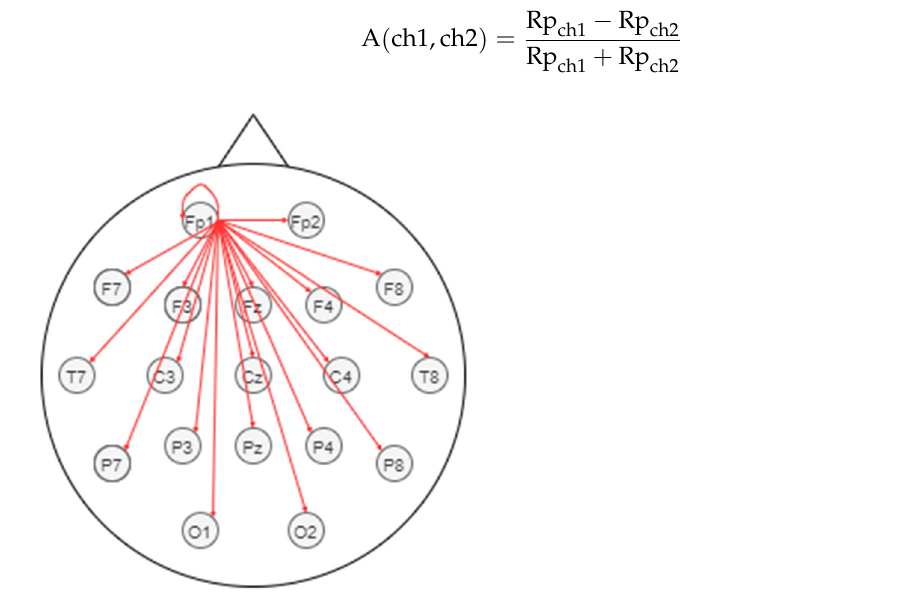
Figure 3. Example of calculating asymmetry score for each EEG channel. It shows calculating asymmetry between Fp1 and the other channels.